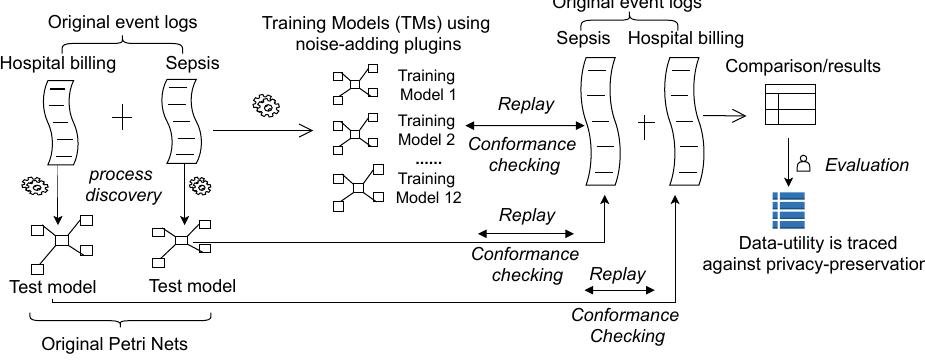
Figure 9. Data analytical approach for third party privacy assurance